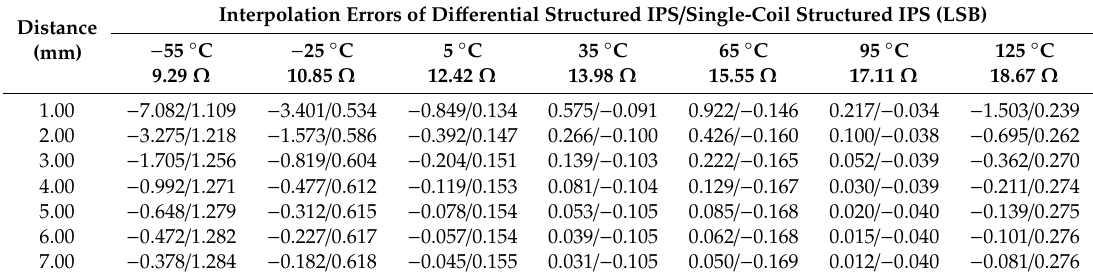
Table 3. Distribution and comparison of interpolation